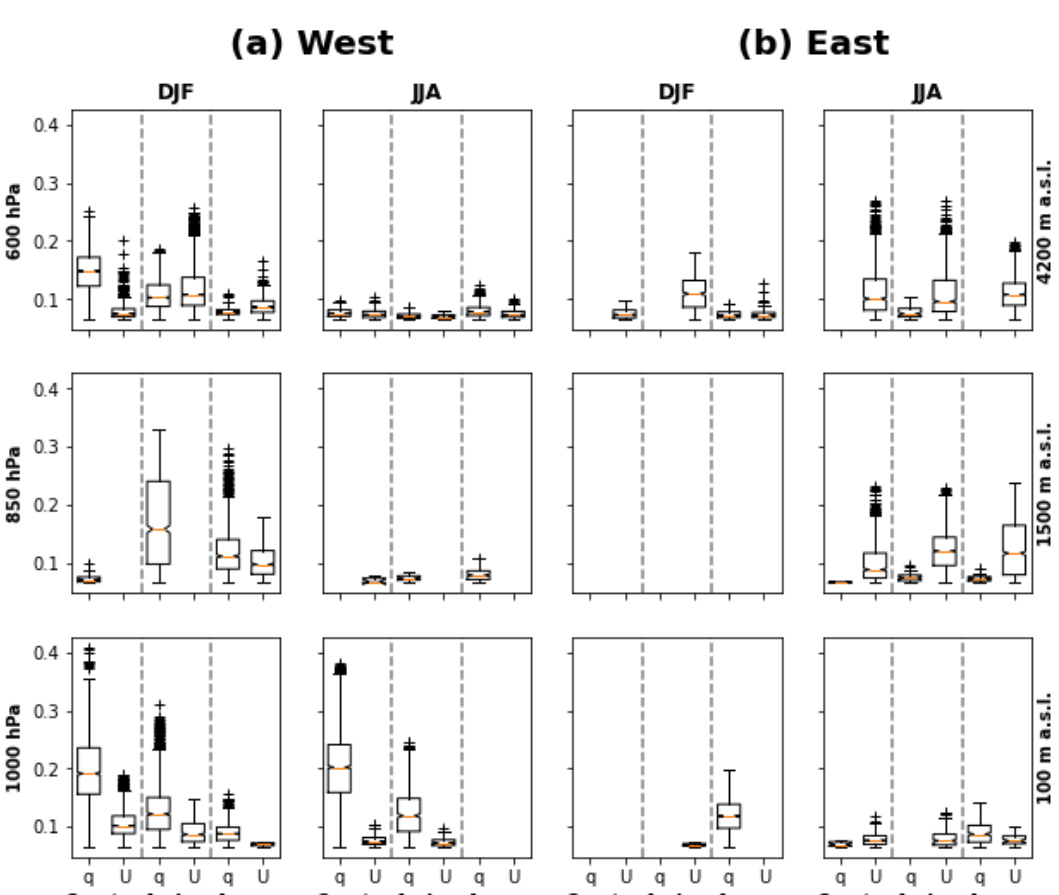
Figure 5. ( a ) GC strength of q and U causal connections in DJF and JJA from pixel P 3,1 (2.5° S, 82.5° W), west of the study area, to rainfall in the three regions of Ecuador (separated by the dashed vertical lines) at altitudes 1000, 850, and 600 hPa (approx. 100, 1500, and 4200 m a.s.l., respectively); ( b ) the same as ( a ) but from pixel P 4,5 (5° S, 72.5° W), east of the study area. The figure only refers to causal connections with p-value ≤ 0.01.